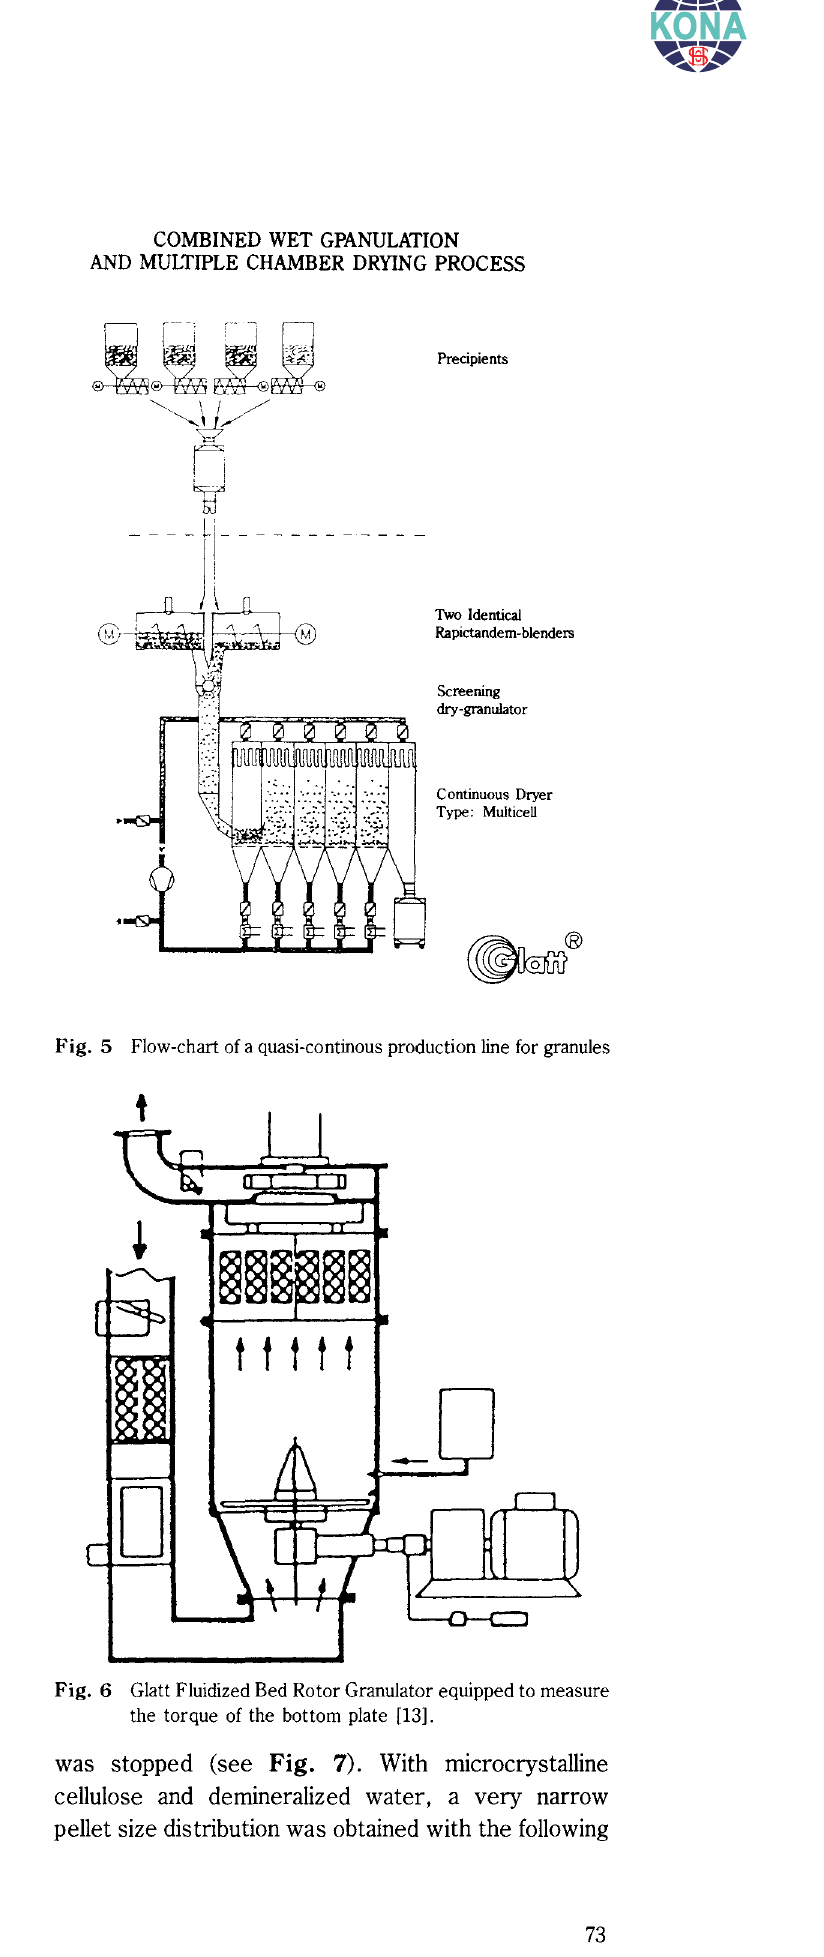
Fig. 6 Glatt Fluidized Bed Rotor Granulator equipped to measure the torque of the bottom plate